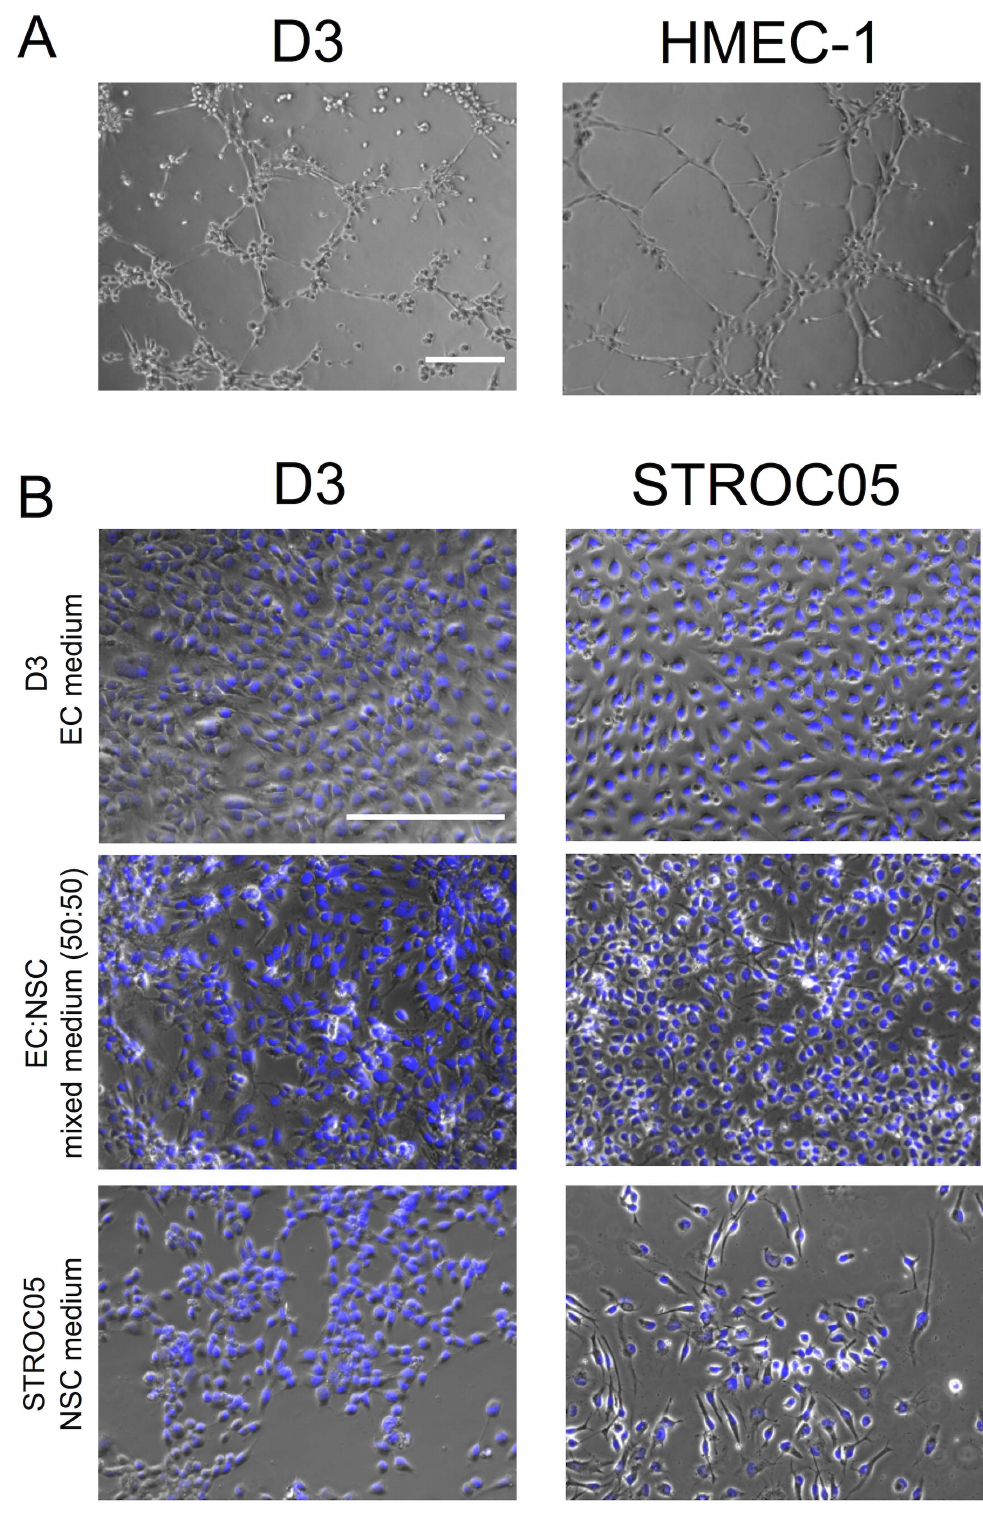
Figure 1. Establishing branching phenotype of endothelial cells and media for coculture with neural stem cells. (A) Matrigel branching morphogenesis assay confirmed the potential for endothelial morphogenesis in D3 human cerebral microvasculature endothelial cells (hCMECs) and HMEC-1 dermal EC lines. (B) D3 hCMECs in EC medium formed a cobblestone-like monolayer on collagen-coated surfaces. D3 hCMECs in NSC medium started to detach from culture surfaces, and STROC05 human neural stem cells (hNSCs) in EC medium lost bipolar elongated morphology. In comparison, morphology of D3 hCMECs and STROC05 hNSCs was maintained in a 50:50 mix of EC:NSC medium. Diamidino-2-phenylindole (DAPI, blue) serves as a nuclear counterstain. Scale bars represent 200 m m.